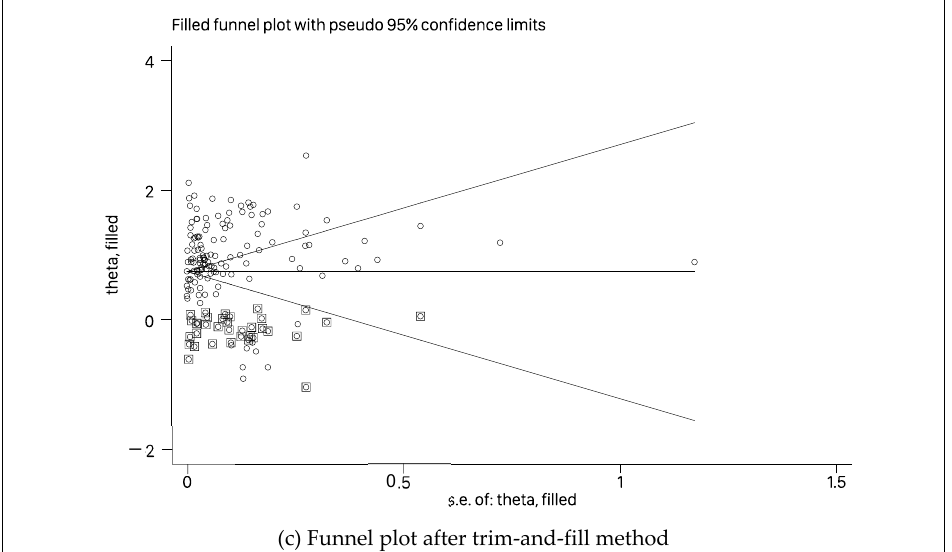
(c) Funnel plot after trim ‐ and ‐ fill method Figure 3. Funnel plot before ( a ) and after ( c ) the trim ‐ and ‐ fill method, and a Doi plot ( b ) for basic reproduction number values based on the random effects model of all studies used to estimate the pooled reproduction number of COVID ‐ 19. Table 1. Sub-group analysis for basic reproduction number ( R 0 ) based on a random effects